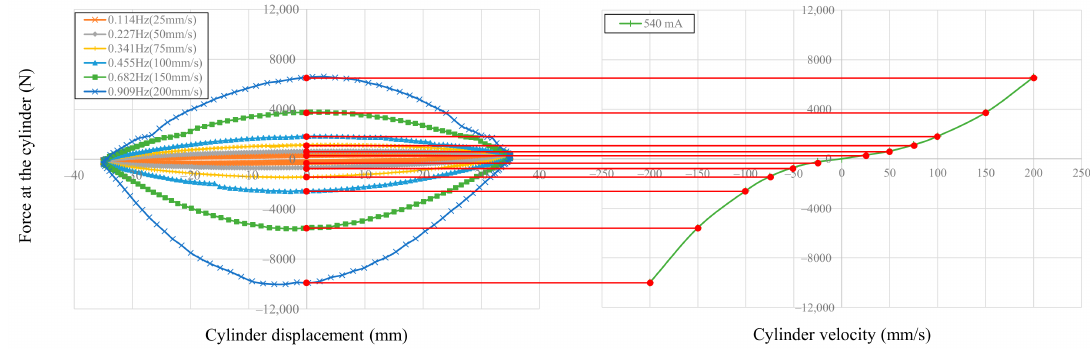
Figure 16. Schematic of method for plotting a force-velocity diagram.